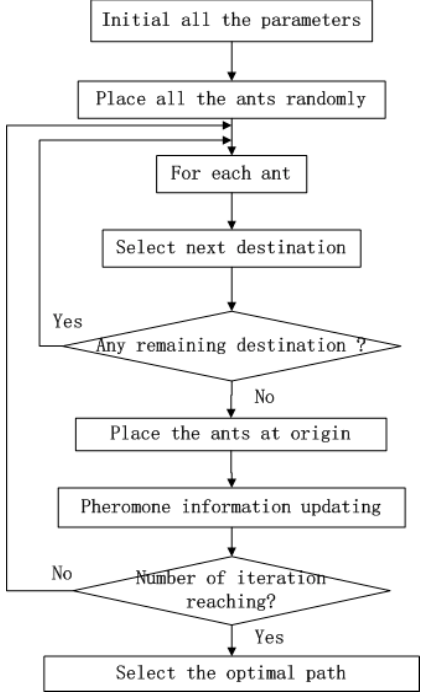
Figure 3. The workflow of ACO .